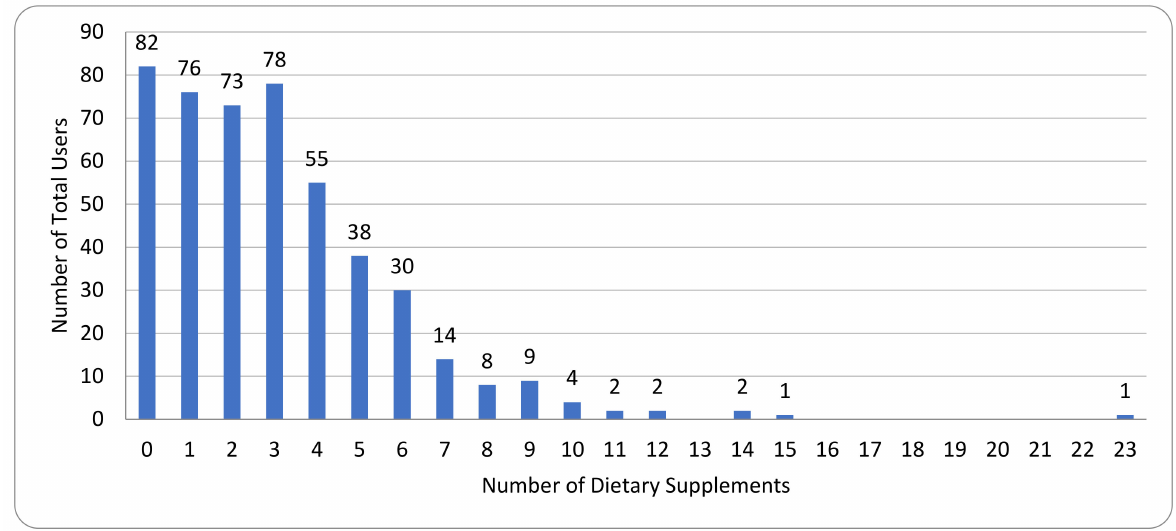
Figure 1. Dietary supplement use at baseline ( n =